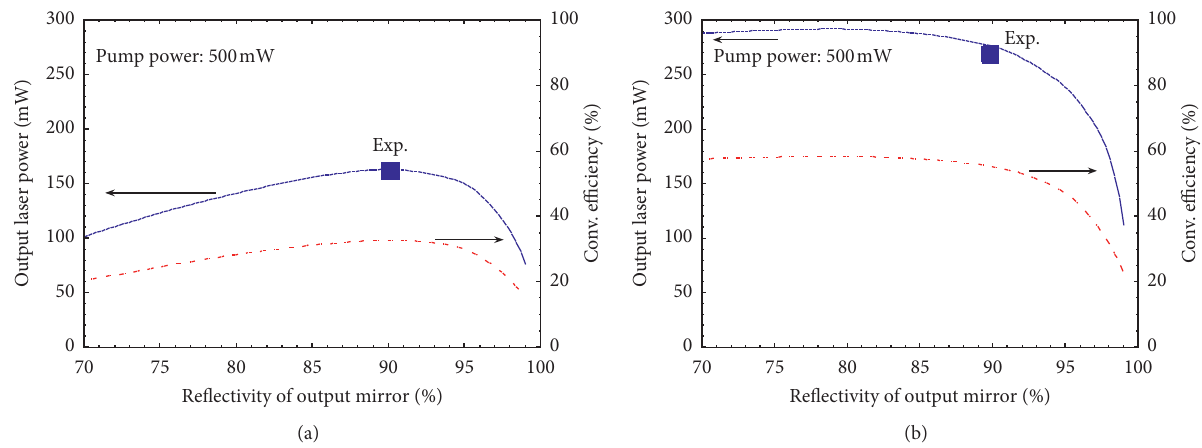
Figure 4: Calculated output laser power and conversion efficiency for the reflectivity of output mirror: (a) Nd:YAG and (b) Nd:YVO